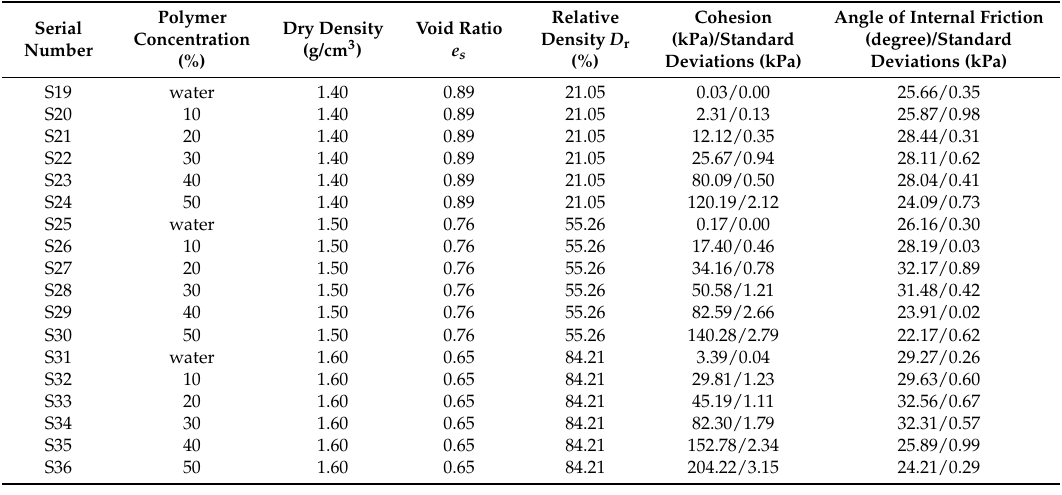
Table 2. Results of direct shear tests.